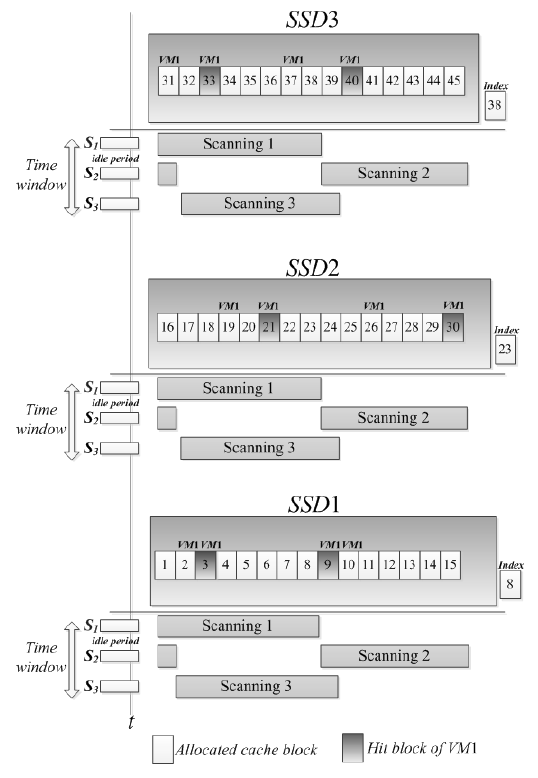
Fig. 5. An example of scanning for the estimation of HLP